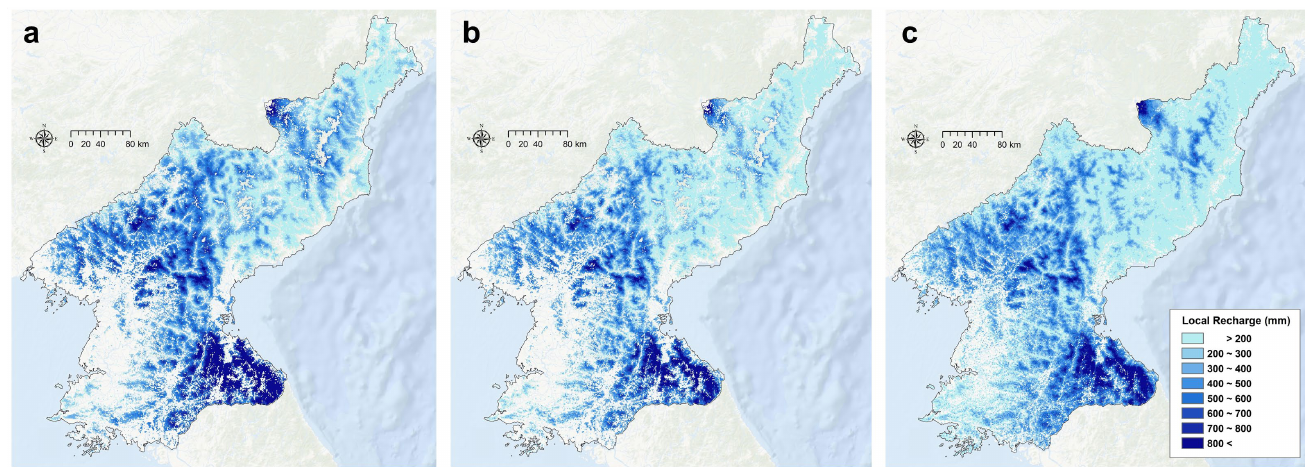
Figure 3. Spatial distribution of local recharge (L) in the forest area: ( a ) baseline period (1981–2010), ( b ) climate change (2041–2070), and ( c ) climate and afforestation scenario (Level 3, 2041–2070).